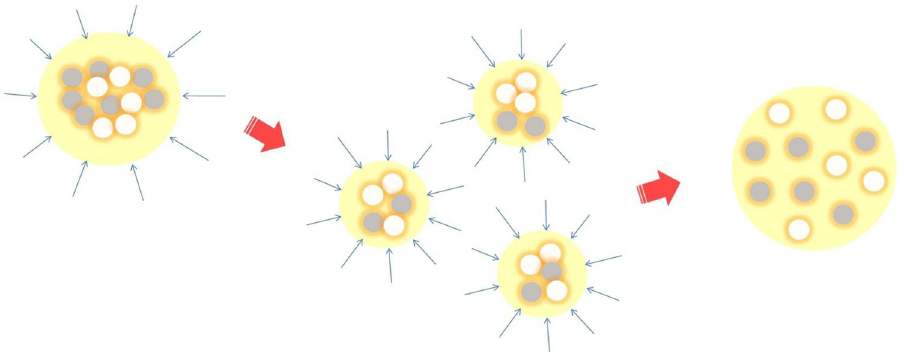
Figure 2. A heterogeneous granule is progressively divided into smaller fragments while being under uniform pressure (blue arrows) during the extrusion process. The large yellow colored spheres represent the linear low density polyethylene, whereas the grey and white colored circles represent two types of nanoparticles. The orange color coating encompassing the nanoparticles is the thin PAA film, present during the extrusion process ◦ as long as the temperature is kept below 250 C.